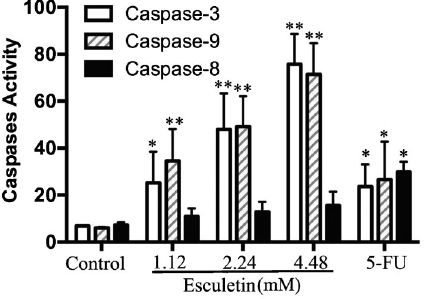
Figure 5. Effect of esculetin on the activity of caspases in SMMC- 7721 cells. SMMC-7721 cells were grouped and harvested after esculetin (0, 1.12, 2.24, and 4.48 mM) and 5-FU (0.77 mM) treatment for 48 h. The caspase activities induced by esculetin